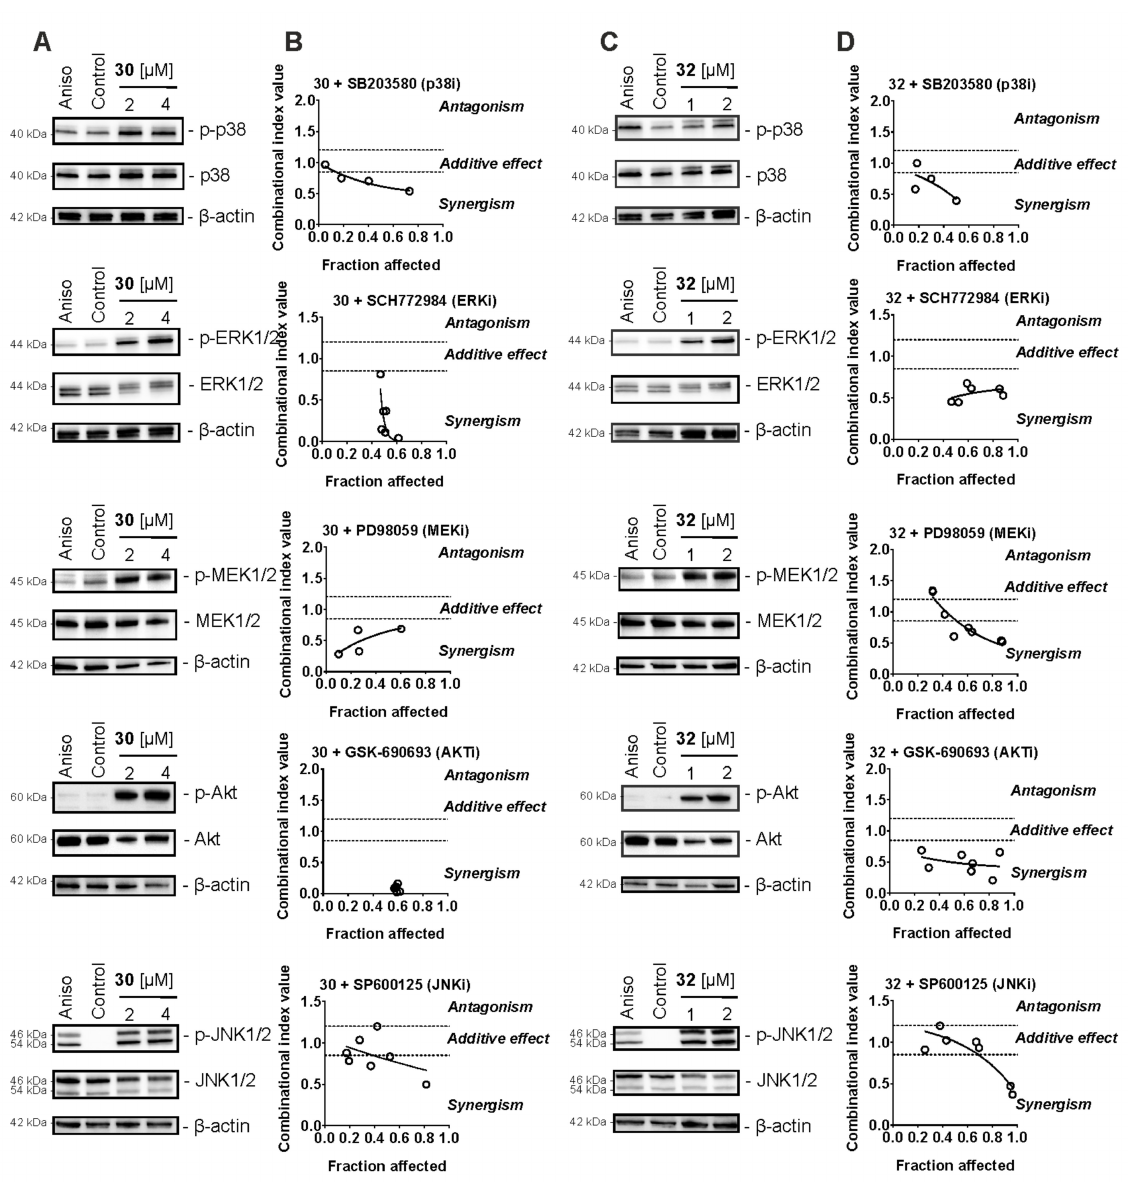
Figure 4. Analysis of the effect of compounds in combination with MAP kinases inhibitors (MAPKi). ( A , C ) 22Rv1 cells were treated with 30 ( A ) or 32 ( C ) for 2 h and the protein expression was analyzed by Western blotting. β -Actin was used as a loading control. Anisomycin (10 µ M) was used as a positive control. ( B , D ) 22Rv1 cells were co-treated with 30 / 32 in combination with the JNK1/2 inhibitor SP600125, p38 inhibitor SB203580, MEK1/2 inhibitor PD98059, ERK1/2 inhibitor SCH772984, or AKT inhibitor GSK-690693 for 48 h. The viability was measured using the MTT assay and the effect of the drug combination was analyzed using CampuSyn 1.0